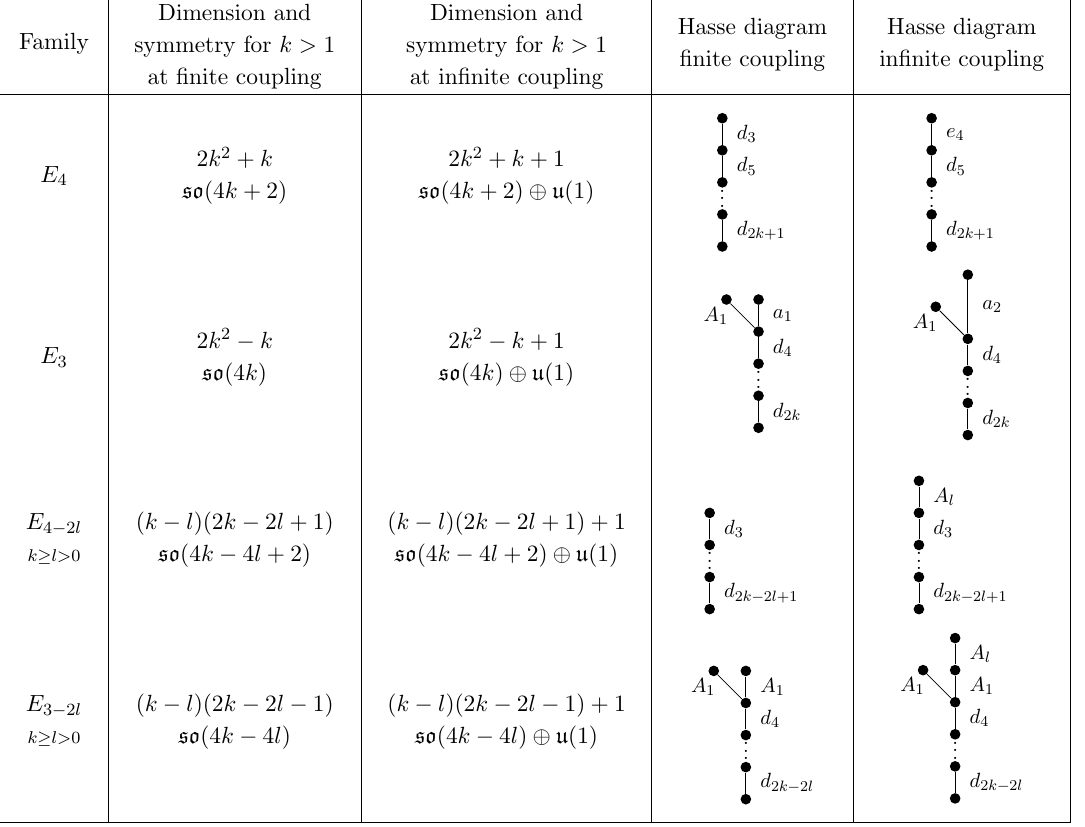
Table 3 . Coulomb branch quaternionic dimension, global symmetry and Hasse diagram for the orthogonal exceptional families, both at (cid:12)nite and in(cid:12)nite gauge coupling. The Hasse diagrams